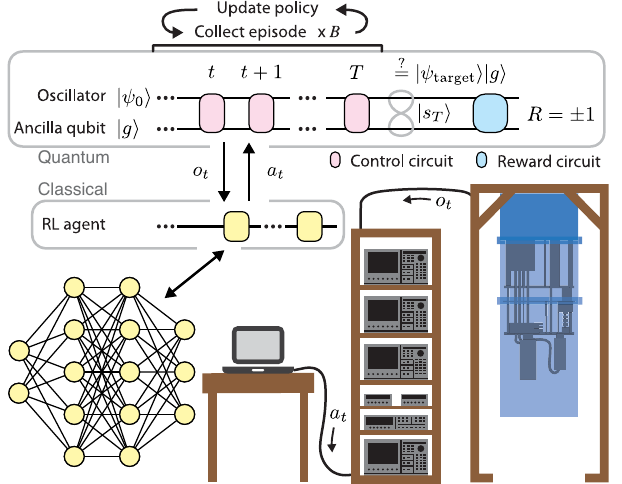
FIG. 1. Pipeline of classical reinforcement learning applied to a quantum-observable environment. The agent (yellow box), whose policy is represented with a neural network, is a program implemented in a classical computer controlling the quantum system. The quantum environment of the agent consists of a harmonic oscillator and its ancilla qubit, implemented with superconducting circuits and cryogenically cooled in the dilution refrigerator. The goal of the agent is to prepare the target state j ψ target i of the oscillator after T time steps, starting from initial state j ψ 0 i . Importantly, the agent does not have access to the quantum state of the environment; it can only observe the environment through intermediate projective measurements of the ancilla qubit yielding binary outcomes o . The agent controls t the environment by producing, at each time step, the action vector a of parameters of the control circuit (pink box). The reward R t for the RL training is obtained by executing the reward circuit (blue box) on the final state j s prepared in each episode. This T i circuit is designed to probabilistically answer the following g i ? ” A question: “ Is the prepared state j s equal to j ψ T i target ij batch of B episodes is collected per training epoch and used in the classical optimization loop to update the